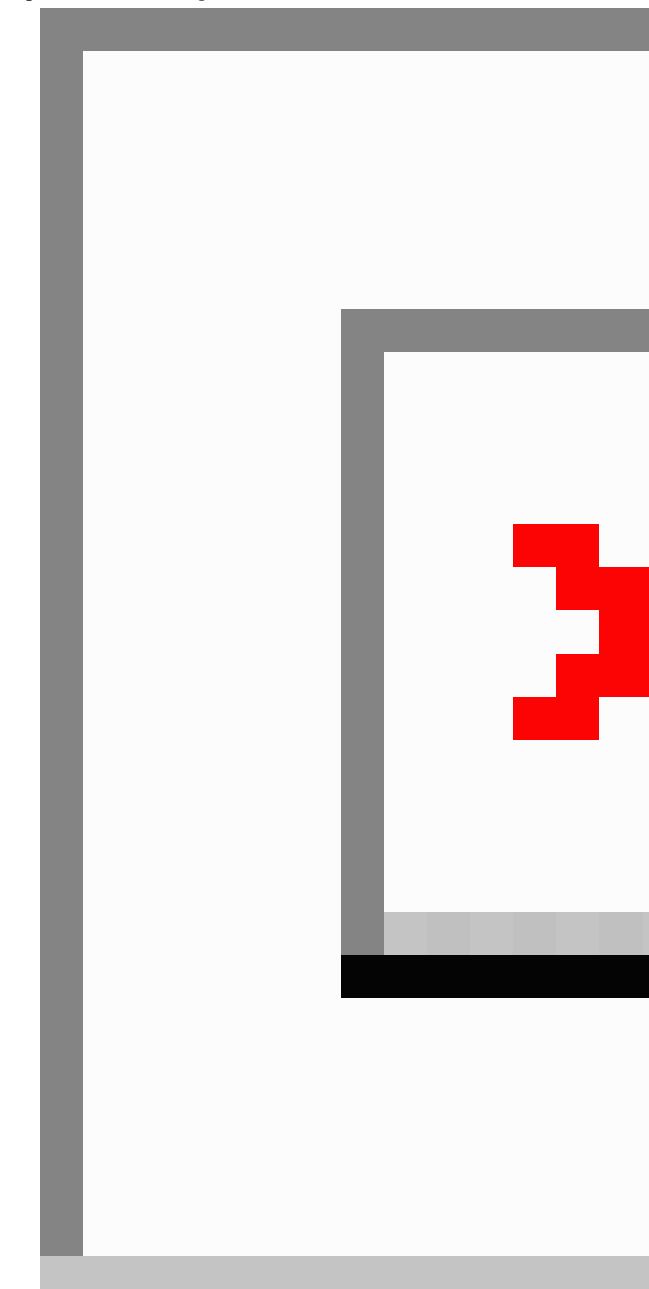
Figure 2. Internet usage rate and number of